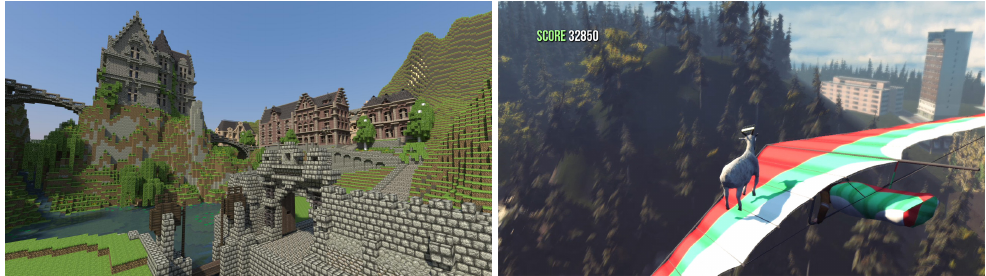
Figure 5. ( Left ) An example world constructed in Minecraft. Similar to Lego TM blocks, no rule forces players to build anything specific. Creations come out of personal will, just because the game allows them. ( Right ) In Goat Simulator there is no specific reward for jumping over an ultralight but